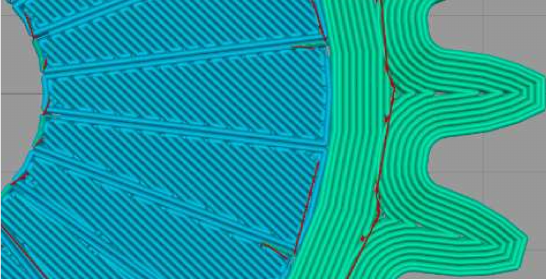
Figure 27. Optimized tool-path for spur